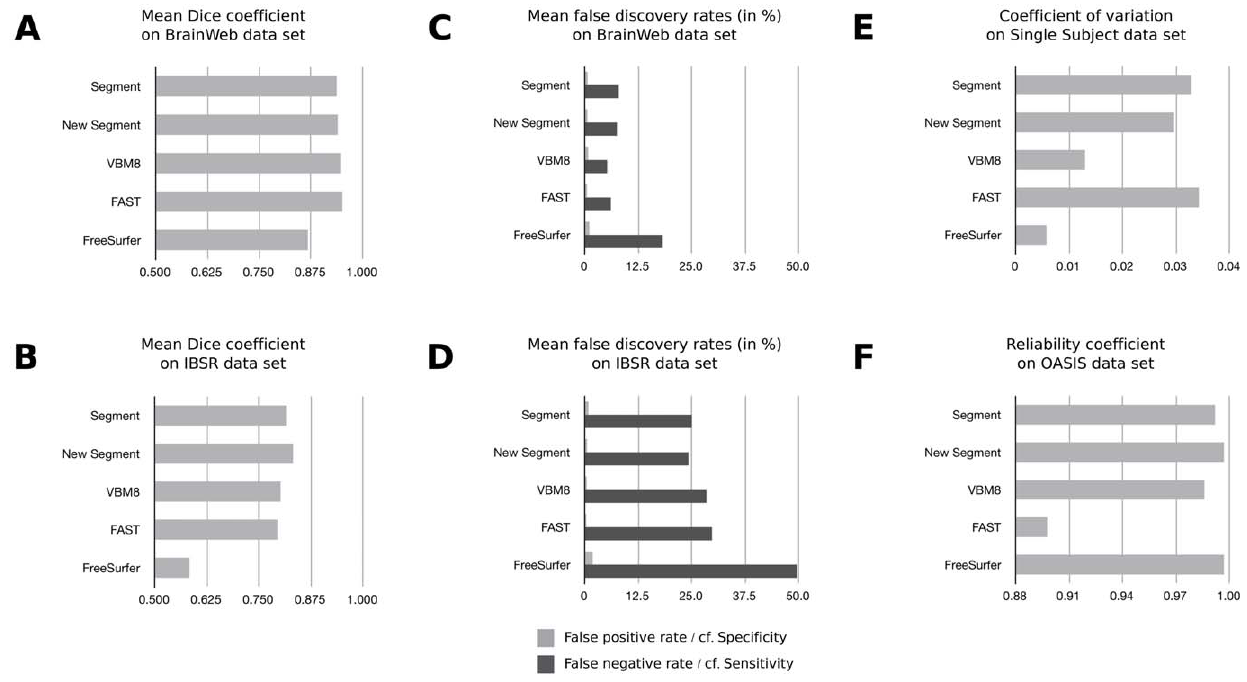
Figure 2. Overview of the results for the five segmentation algorithms in default mode. Depicted is the mean Dice coefficient that was reached by each of the five standard segmentation algorithms in its default mode on the BrainWeb images (Panel A) and on the IBSR data set (Panel B). Panel C and D summarize the average false positive rate f p and the average false negative rate f n for each segmentation algorithm on the Brain Web data set (Panel C) and on the IBSR images (Panel D). Panel E shows the coefficient of variation for gray matter volumes detected in the Single Subject data set. For each segmentation algorithm, Panel F depicts the test-retest reliability determined on the OASIS data set.